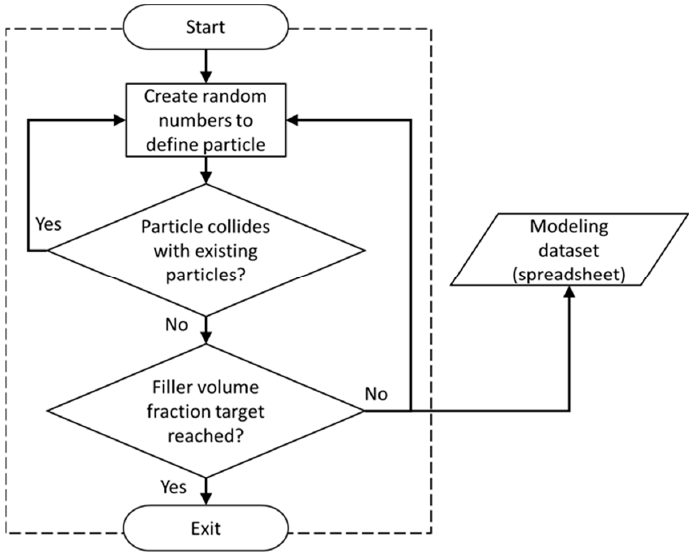
Figure 3. A schematic illustrating the Random Number Generator (RNG) module [58].